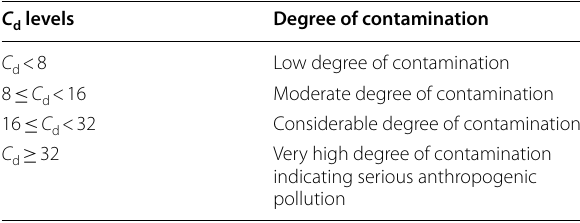
Table 6 Classification of degree of contamination